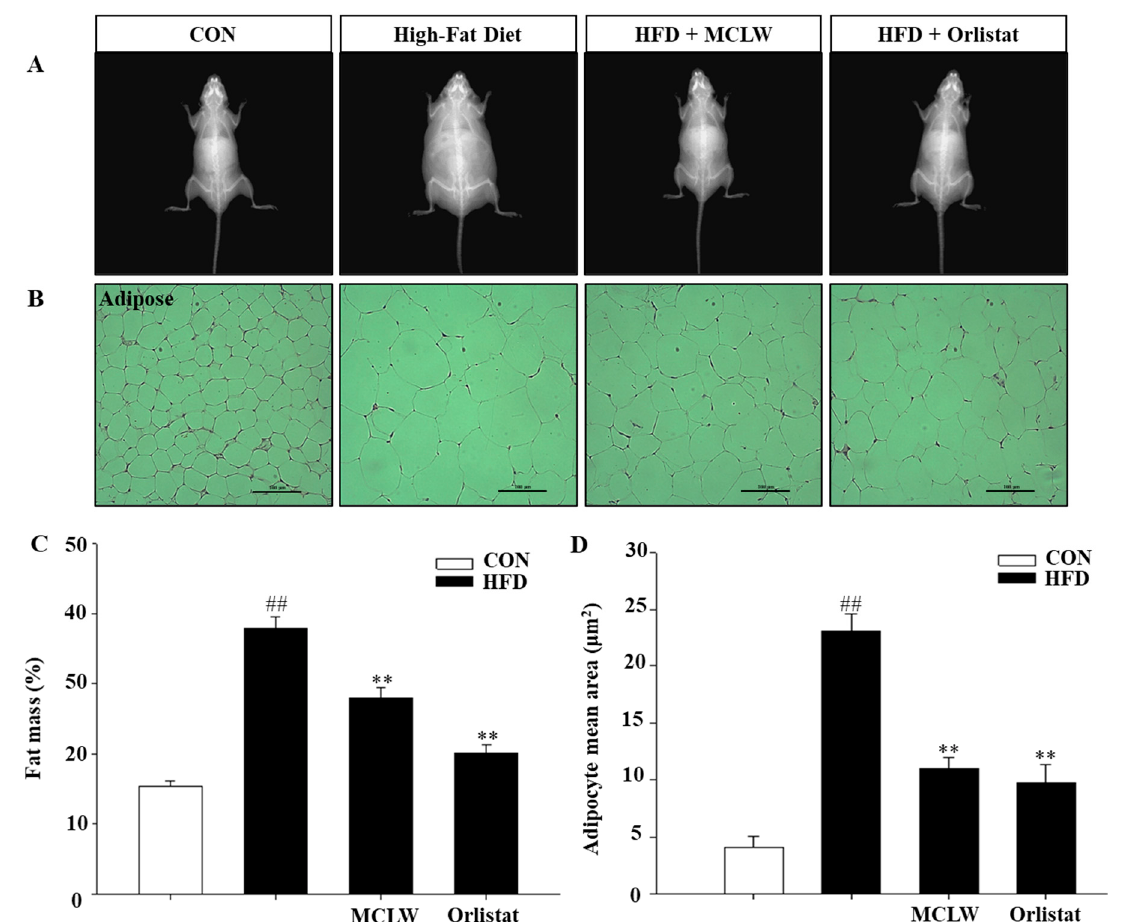
Figure 5. Changes in fat mass and adipocyte size in mice from normal and HFD diets groups, CON groups were fed normal diet, HFD groups fed high fat diet, HFD with MCLW 200 mg/kg, and HFD with Orlistat 60 mg/kg. ( A ) The radiography of body fat is displayed. ( B ) MCLW reduces lipid accumulation in the adipose tissue. ( C ) Fat mass values are reported relative to the body weight ( n = 8 per group). ( D ) Adipocyte mean area ( µ m 2 ) ( n = 3 per group). Data are mean ± SEM. Student’s unpaired t -test with Benjamini–Hochberg correction, ## p < 0.01 vs. the normal diet (CON); ** p < 0.01 vs. the HFD ( n = 8).